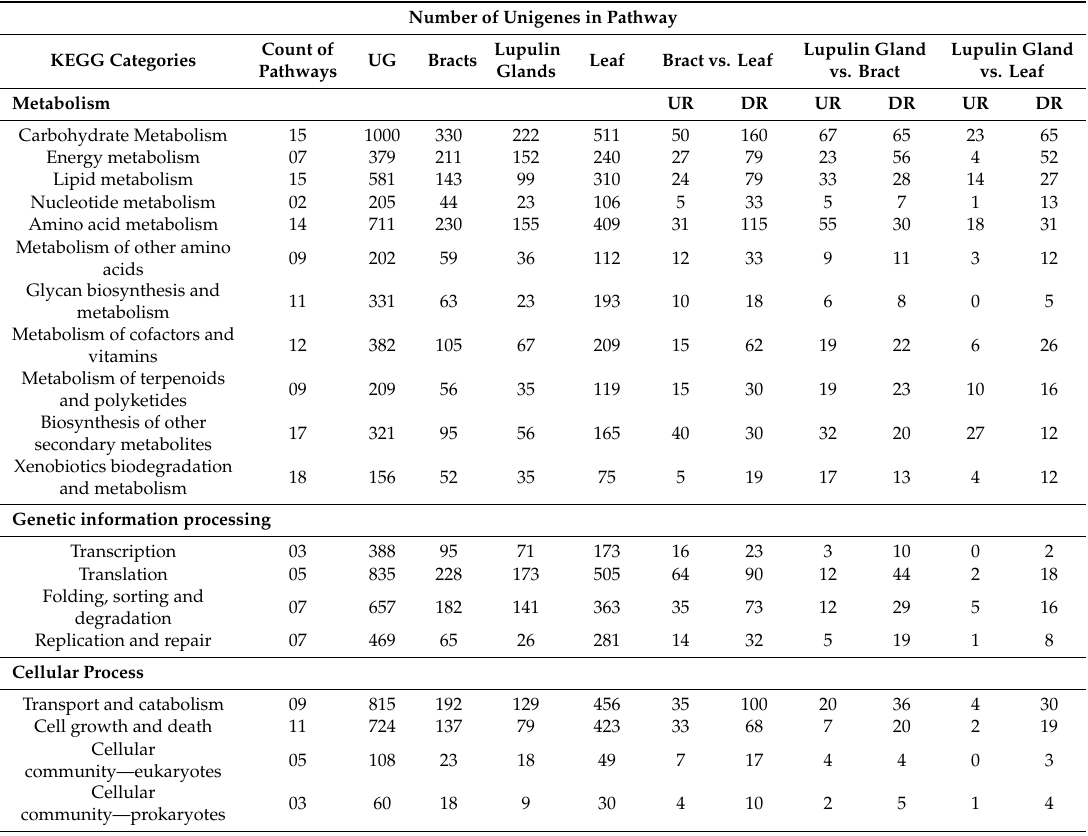
Table 2. Classification statistics for unigenes (UG) and di ff erentially expressed genes (up-regulated (UR) and down-regulated genes (DR)) in leaf vs. bract according to KEGG pathway analysis. Number of Unigenes in Pathway Lupulin Lupulin Gland Lupulin Gland Count of Leaf Bract vs. Leaf KEGG Categories UG Bracts Glands vs. Bract vs. Leaf Pathways